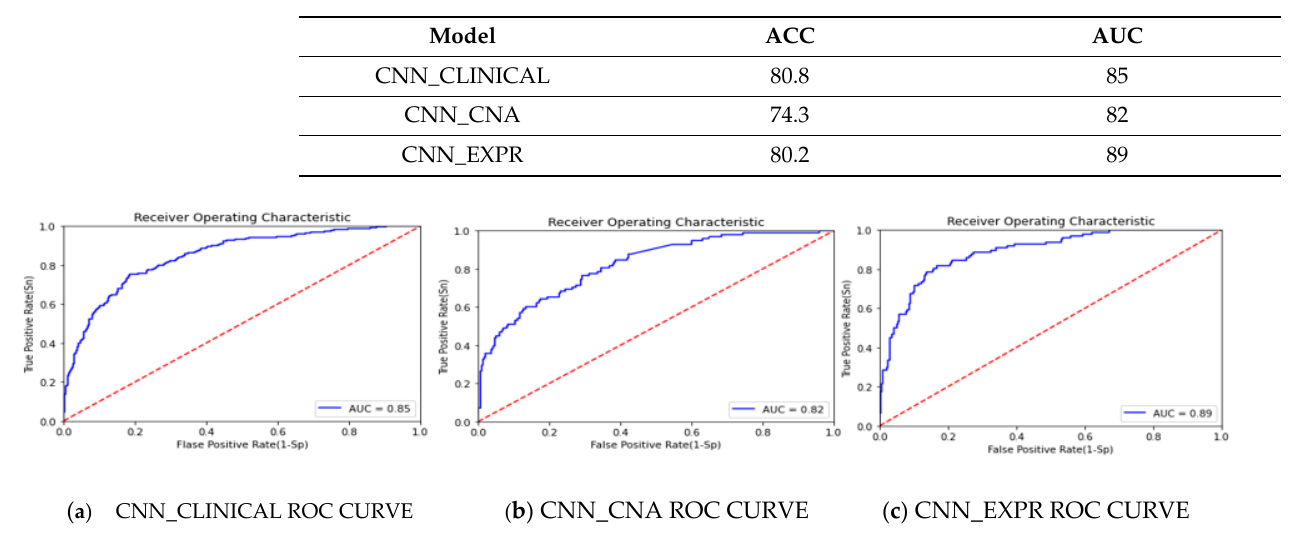
Figure 3. ROC curves and AUC values of CNNs trained on each data modality.